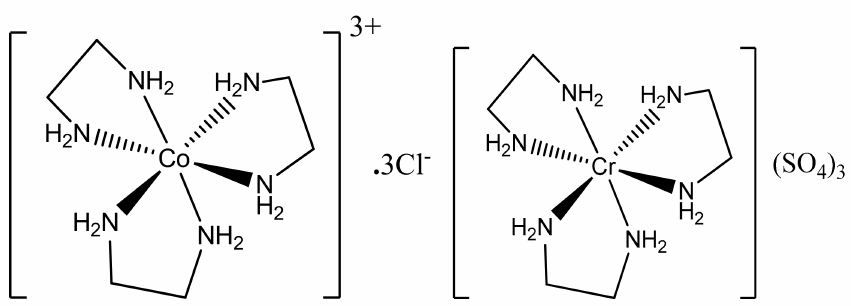
Figure 1. Tris(ethylenediamine)cobalt(III) chloride and tris(ethylenediamine)chromium(III) sulfate.